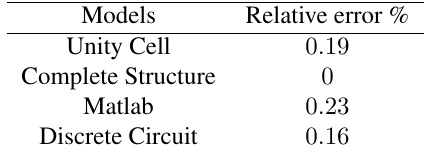
Table 1: Relative error from simulated and theoretical mo-